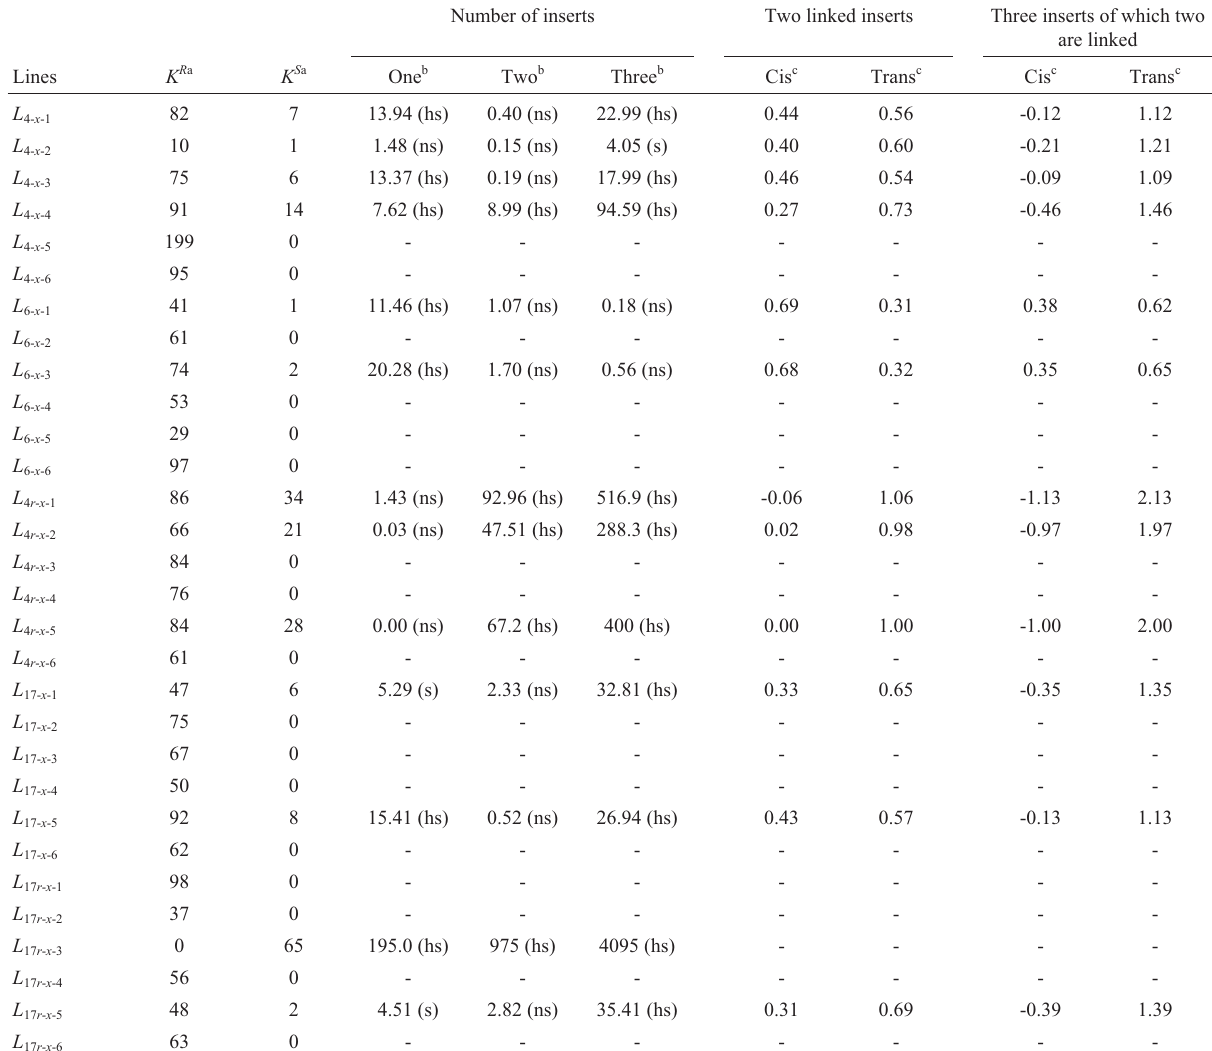
Table 7 - Segregation ratios, (cid:3) 2 test results and distances between linked inserts (Morgan) in the T3 generation. Number of inserts Two linked inserts Three inserts of which two